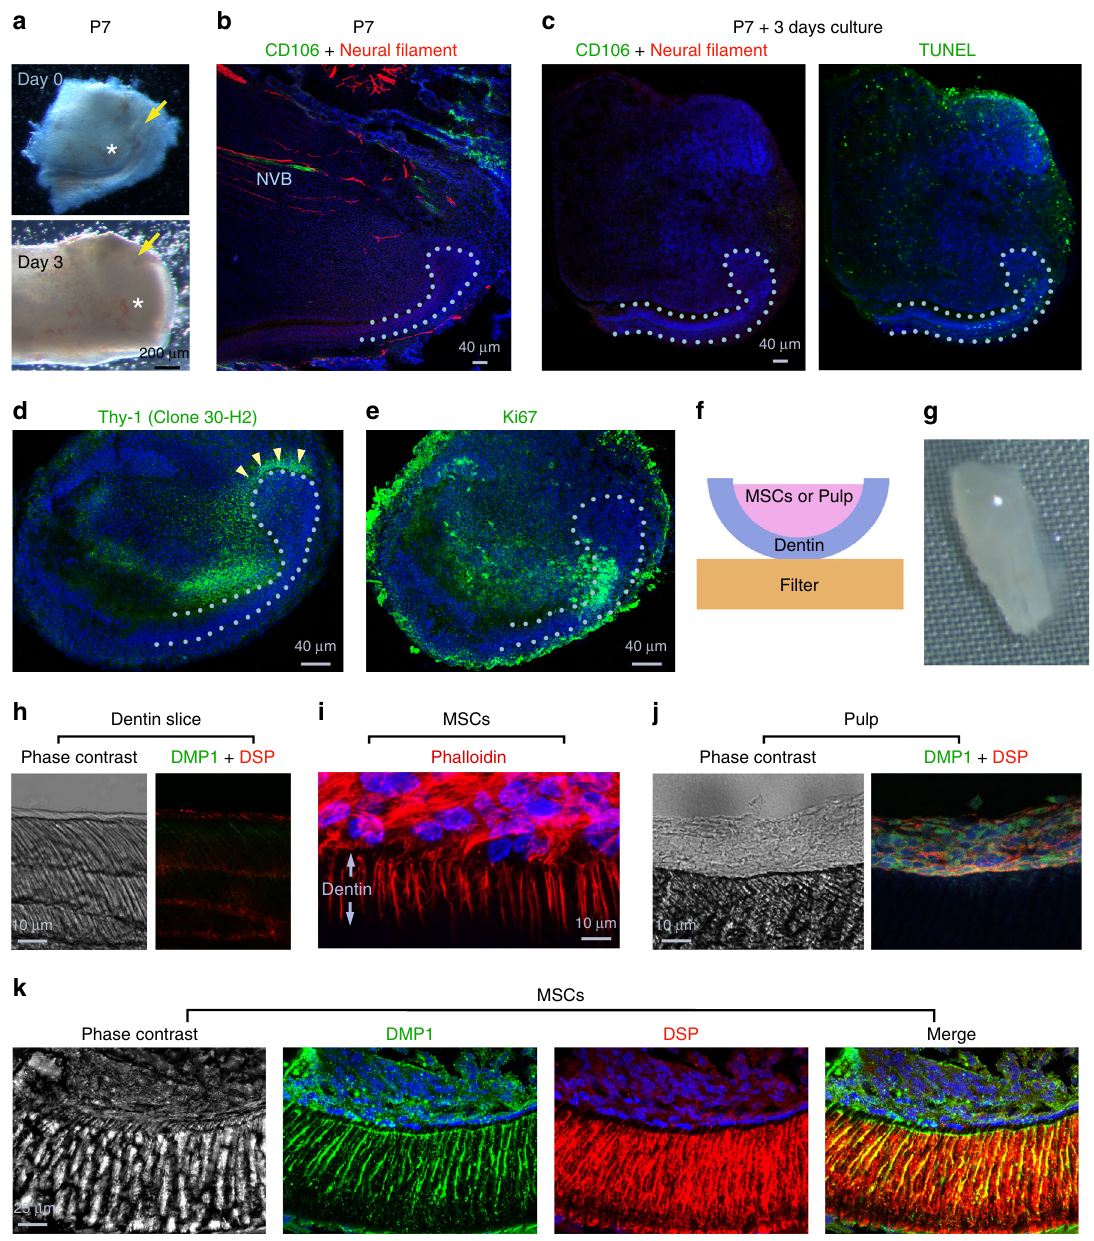
Fig. 2 CL-MSCs contribute to mouse incisor tooth growth and odontoblast differentiation. a Representative micrographs for a P7 incisor CL before (day 0) and after 3 days of culture (Day 3). Note the signi fi cant expansion of MTACs region after 3 days (white asterisks). Yellow arrows indicate CLs. b Immuno fl uorescence analysis of indicated markers in the P7 CL region. Nuclei were counterstained with DAPI. Light blue dotted line shows epithelial – mesenchymal junction. NVB neurovascular bundle region. c – e Immuno fl uorescence analysis and TUNEL assay of indicated markers in the cultured CL as shown in a . TUNEL was performed on the same sample showed in c after CD106 and Neural Filament staining and exposure to light to bleach the staining. Light blue dotted line shows epithelial – mesenchymal junction. f Schematic indication of in vitro dentin slice-based differentiation assay model. g Stereo view of a recombined dentin slice with a fresh CL-MSC tissue. h Phase contrast pictures of decellullar dentin slice (left), and DMP1 and DSP immunostaining on the slice (right). i CL-MSCs cultured on dentin slice for 4 days and stained with phalloidin-Alexa 568 (actin) and DAPI (nucleus). j , k Pulp cells ( j ) or MSCs ( k ) were combined with dentin slices and cultured for 7 days prior the immunostaining for DMP1 and DSP. Nuclei were counterstained with DAPI. Corresponding phase contrast images are shown. Note while DMP1 and DSP remained within tooth pulp cell layer, numerous cellular processes are invading dentin slice when MSCs are used. Bars: a : 200 μ m; b – e : 40 μ m; h – j : 10 μ m; k : 25 μ cells only retained on the surface of the dentin slices (Fig. 2j), the CL-MSC-derived cells fully polarized and secreted Dentin Sialo formation, we performed chimeric-like tissue culture by recom- Protein (DSP) and Dentin Matrix Protein 1 (DMP1) (Fig. 2k). bining freshly isolated CL-MSCs with devitalized dentin slice The application of SCs in tissue engineering and regenerative (Fig. 2f, g) 25 . We observed a rapid polarization of the CL-MSCs medicine often requires overcoming the major challenge of by producing branched protrusions into the dentin slices after amplifying the cells in vitro without losing their pluripotency and only 4 days in culture (Fig. 2h, i). At day 7, while the tooth pulp